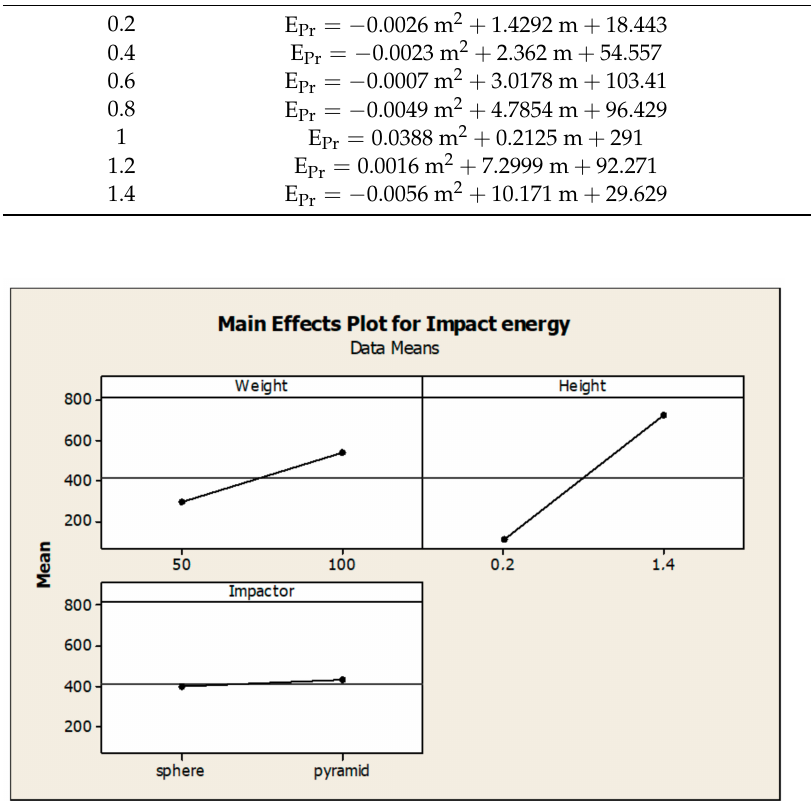
Figure 15. Graphical representation of the main effects.